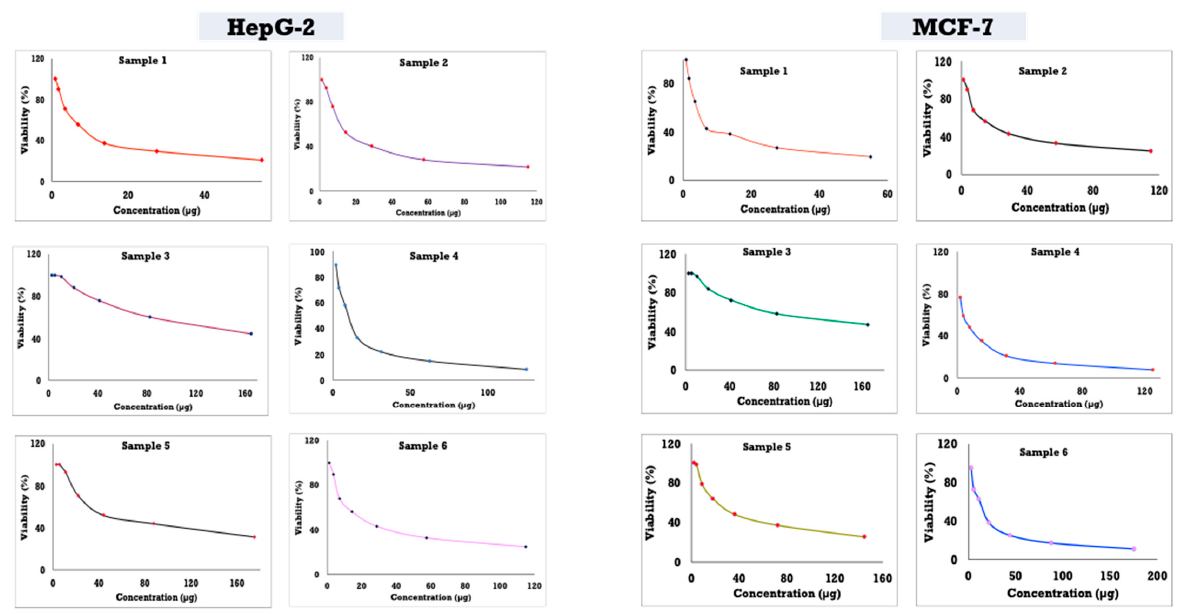
Figure 8. Cytotoxicity of different concentrations of anise oil-based nanoemulsion. Table 6. Cytotoxicity activity of anise oil-based nanoemulsions against two cell lines, HepG2 and MCF7.